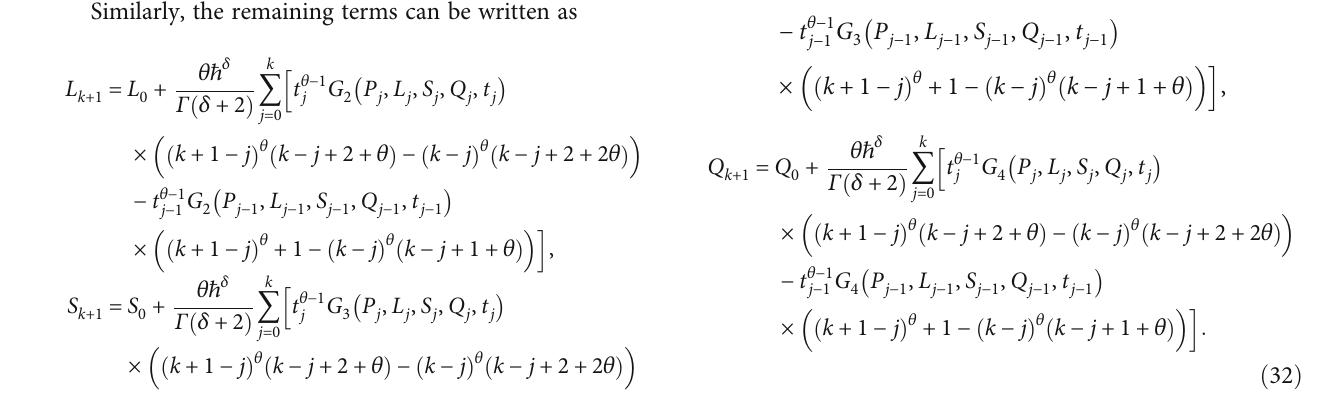
Figure 3: Graphical representation of smokers ( S ð t Þ ) having two di ff erent initial values of L di ff erent arbitrary fractal dimension and fractional